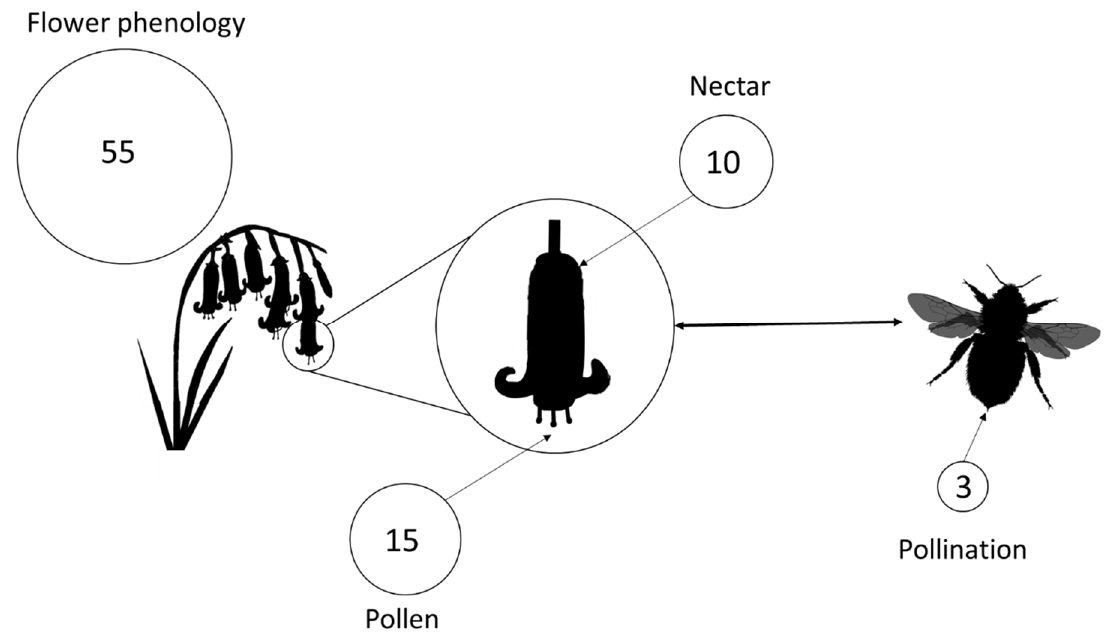
Figure 1. Components of common bluebell, Hyacinthoides non-scripta , pollination interaction and the number of published studies (on any species) considering the impact of eCO 2 on each component. The area of the circle is proportional to the number of studies.